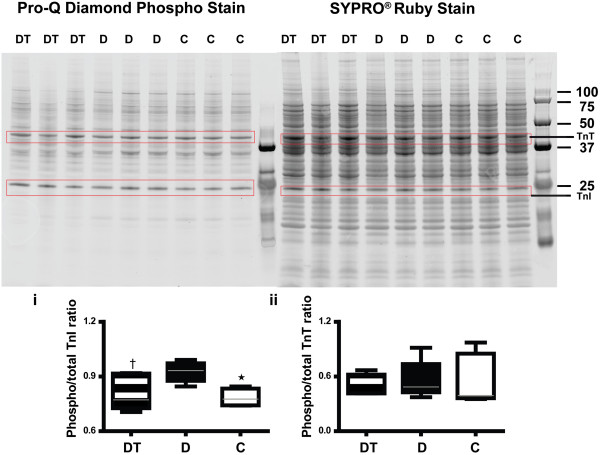
Gel electrophoresis of LV extracts from treatment groups of rats. Gels were stained with Pro-Q Diamond (for phosphoproteins) and SYPRO® Ruby (for total protein). Upper panels show representative gels (n = 3/group). Lower panels show graphical representation of the results of densitometry: (i) Diabetic animals (D, n = 6, solid bars) showed increased proportions of phosphorylated TnI (expected molecular weight, 28 kDa) compared with controls (C, n = 6, open bars) whereas TETA-treated diabetic animals (DT, n = 6, patterned bars) showed levels comparable to control values. (ii) Neither diabetes nor TETA treatment modified the phosphorylation of TnT (expected molecular weight, 40–42.5 kDa). Data in lower panels are means ± SEM analysed by one-way ANOVA (P = 0.005) with post-hoc Tukey’s Multiple Comparisons tests: *, C vs D, P < 0.01; †, D vs DT, P < 0.05. Abbreviations: TnI, troponin I; TnT, troponin T.